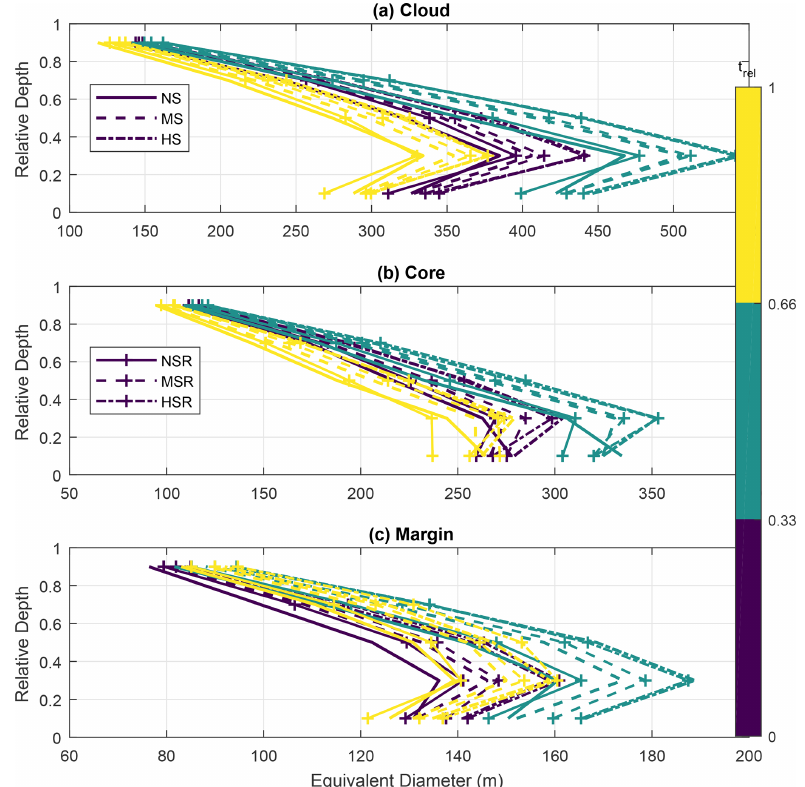
Figure 10. Averaged dimensions of the (a) clouds, (b) cloud cores, and (c) cloud margins as a function of the cloud life cycle and relative depth. The relative depth is a normalised height based on cloud base and cloud top. Values of 0 equate to the cloud base, while 1 represents cloud top. We use five relative depth intervals of 0.2, plotting the data points in the centre of them. The cloud life cycle is also normalised ( t rel , in colours), being 0 at the first initial detection by ForTraCC and 1 at its latest time step. We set three life cycle intervals, representing initial, mature, and dissipating stages. The standard deviations are omitted for figure clarity, but they represent approximately 80% of the averages in the depth interval closest to cloud base, decreasing to about 50% close to cloud